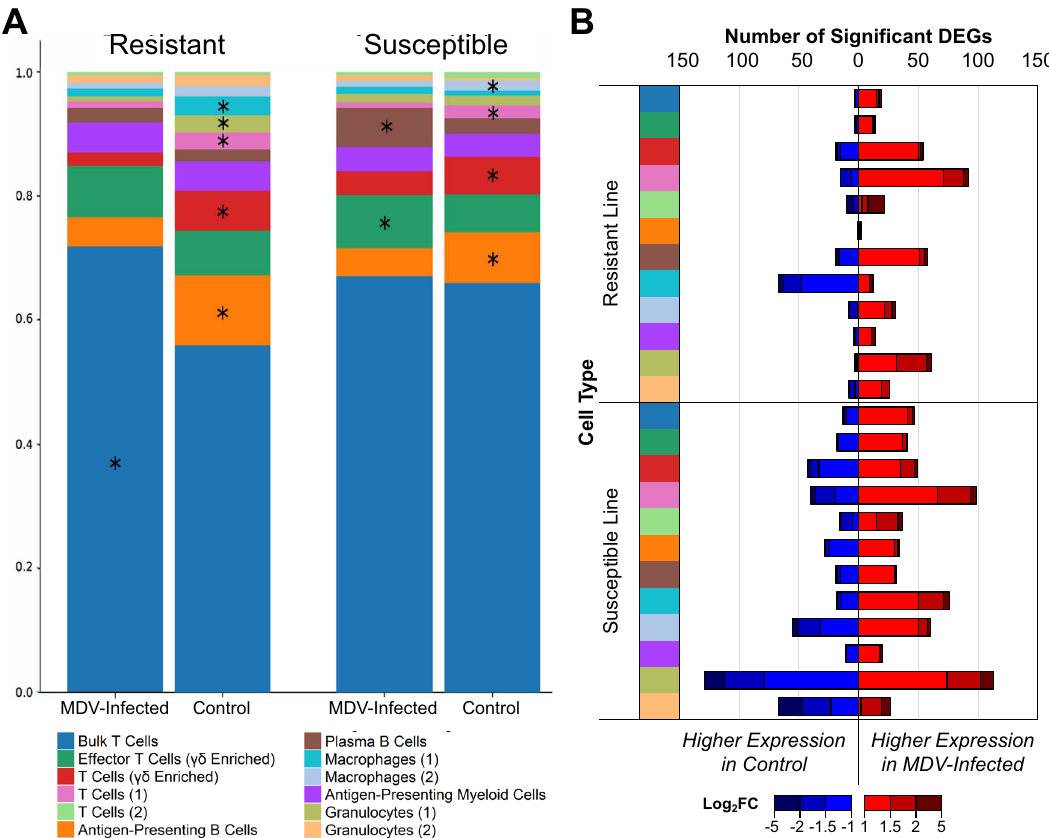
Figure 4. MDV infection shifts cell type composition and gene expression profiles. ( A ) Cell type composition by infection status within the resistant (ADOL 6 3 ) or susceptible line (ADOL 7 2 ). Each cell type is indicated by color according to the key. Within each line, significant differences ( p < 0.05) in abundance between the MDV-infected and controls are marked by asterisks on whichever infection status had higher abundance of that cell type. ( B ) Summary of significant differentially expressed genes (DEGs; |log 2 FC|≥ 1.0, p -adj < 0.01) in MDV-infected compared to control for each cell type within the resistant and susceptible lines (total n = 964). The number of DEGs increased by MDV are represented by the red bars (right side of the plot), while DEGs decreased by MDV are shown in blue (left side). The magnitude of log 2 FC for the DEGs within each bar is further illustrated by binning into the red-blue color